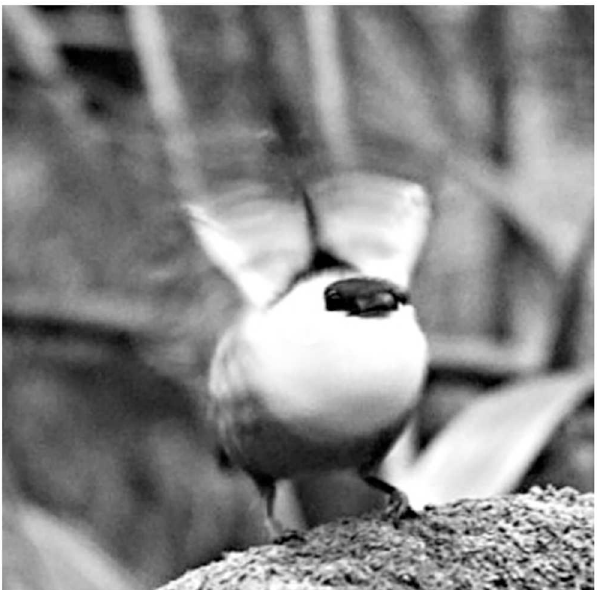
Fig 1. The “rolled snap”display of white-bearded manakin( Manacus manacus ) males used to attract femalesto display arenas.